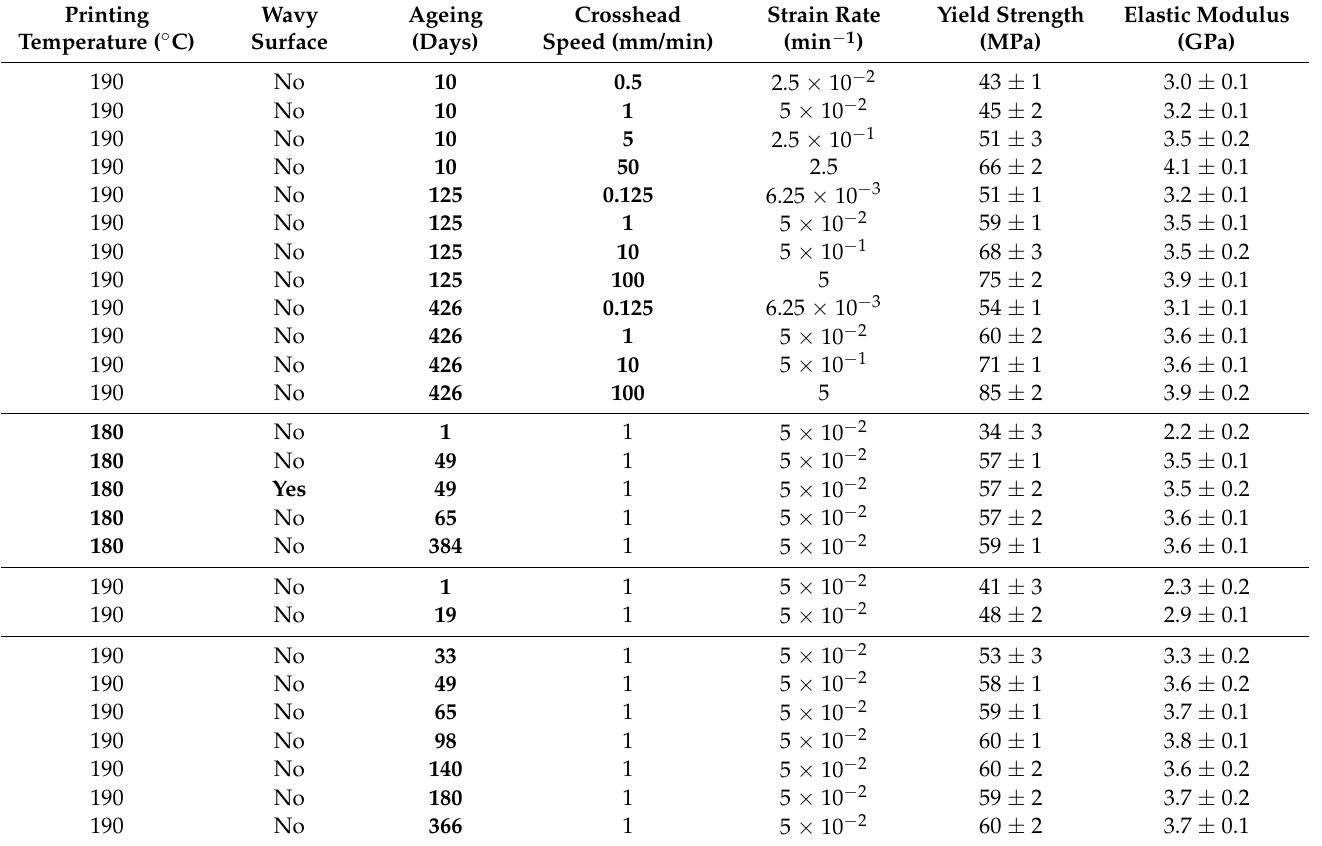
Table 2. Mechanical properties of the PLA, followed by the root-mean-square